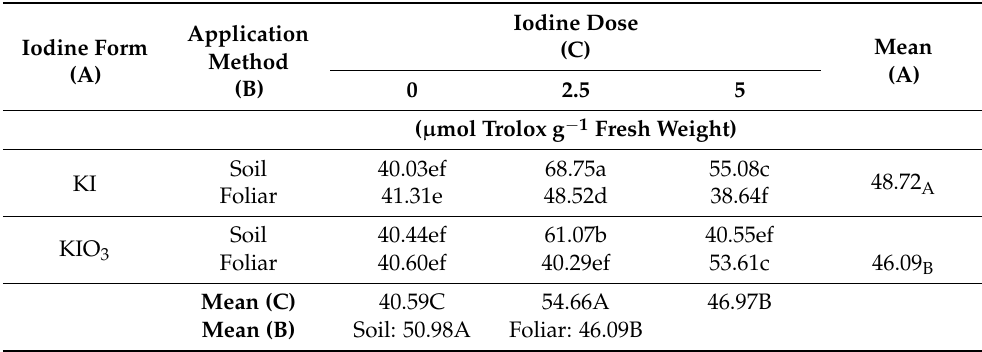
Table 5. Total antioxidant capacity (TAC ABTS) in rye plants depending on I dose, form, and method of